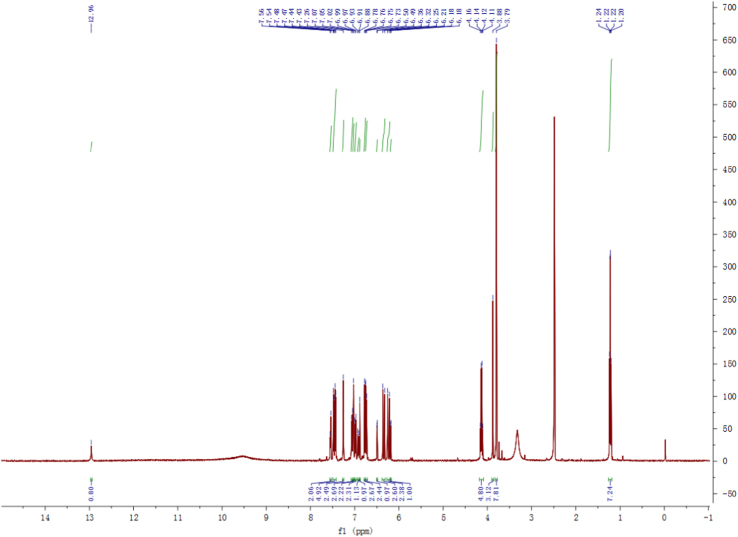
1H-NMR spectrum of compound 3.